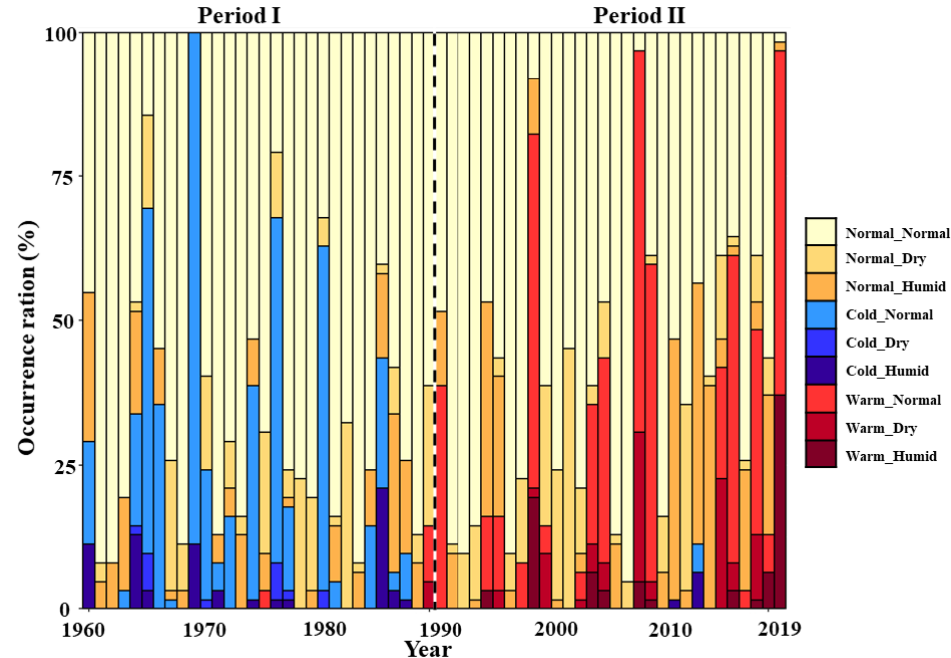
Figure 4. Annual changes in the incidence of normal climate years and 8 climate extremes at 62 meteorological stations in Northeast China from 1960 to 2019.